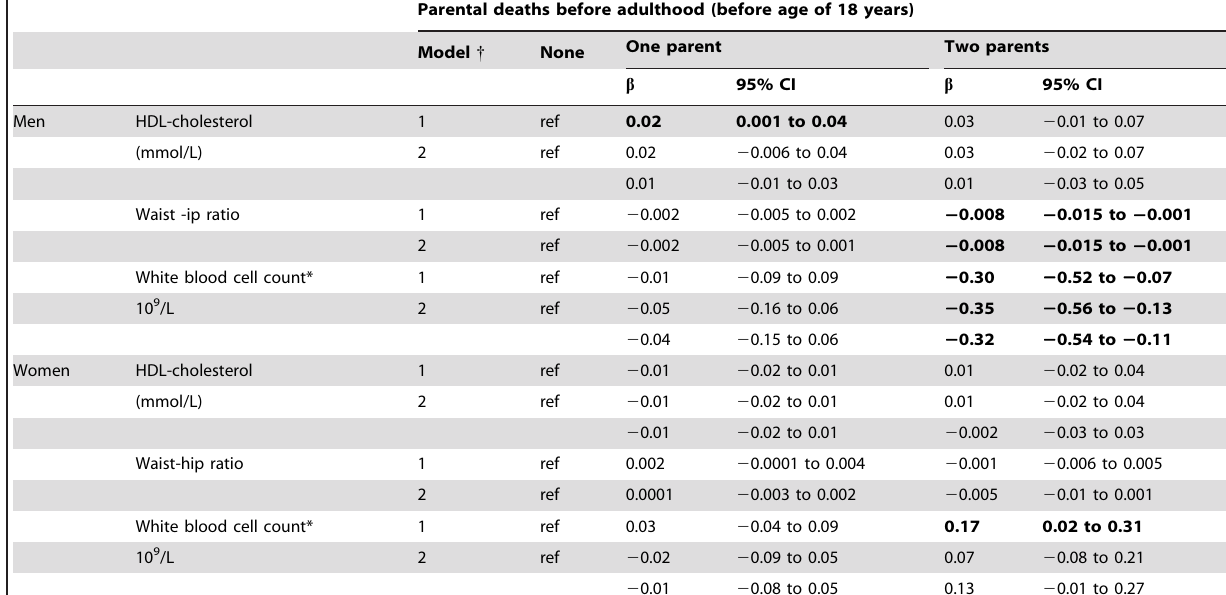
Table 3. Sex-specific adjusted associations of early life parental death with HDL-cholesterol, waist-hip ratio and white blood cell count in 28,771 older Chinese men and women in recruitment phases 1, 2 and 3 of The Guangzhou Biobank Cohort Study (2003–